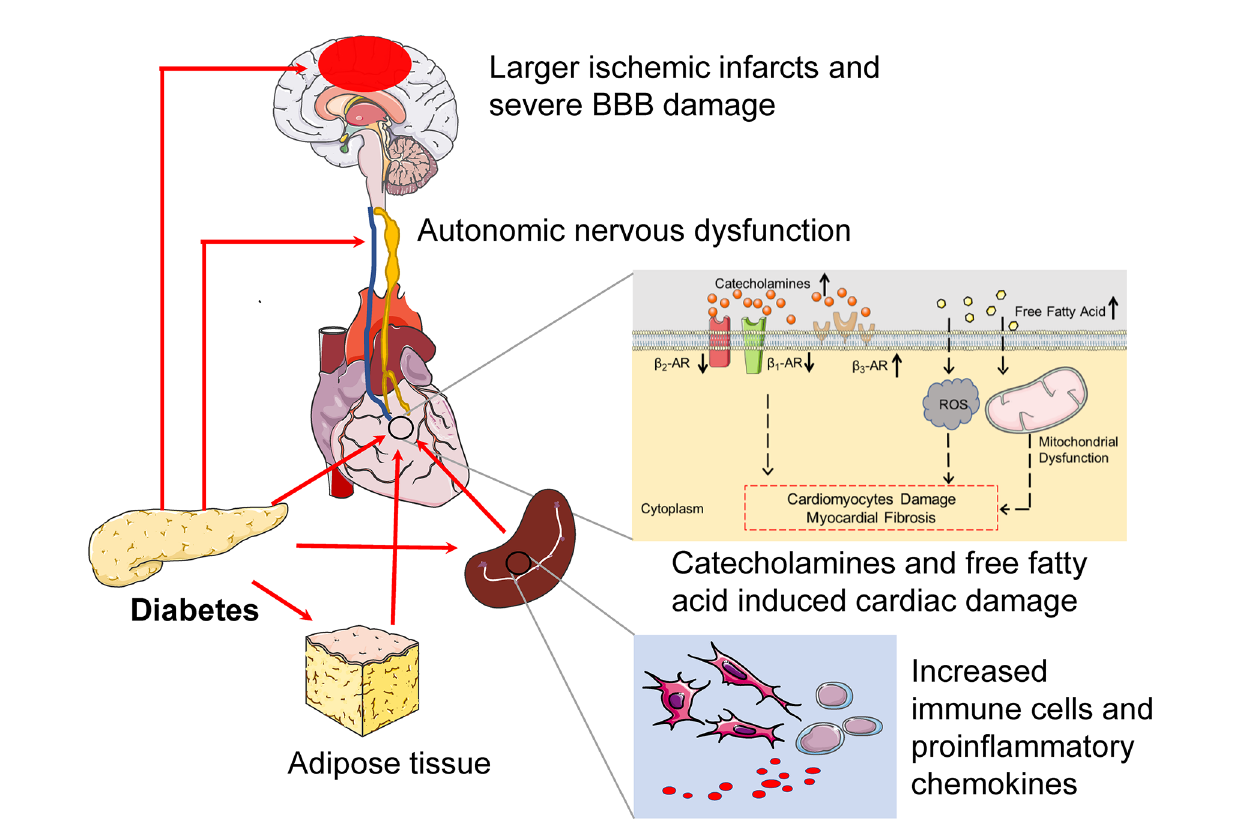
FIGURE 2 | The potential pathogenesis of diabetes exacerbates cerebral-cardiac syndrome. In pre-stroke states, diabetes induces preexisting injury both of the brain and the heart. CAN is a common complication in diabetes, which is characterized by parasympathetic denervation and overactivated sympathetic tone. Furthermore, the expression of b 1 -AR and b 2 -AR decreased, while the b 3-AR increased in the diabetic heart. Diabetes also provides a low-grade systemic in fl ammatory environment, which manifests as increased immune cells and proin fl ammatory cytokine levels. All of these provide a suitable condition for CCS. In the context of diabetes, the larger ischemic infract and severe BBB damage can be detected during the IS onset, which provoke severe systemic in fl ammation and cause severe cardiac in fl ammatory damage. Catecholamines surge also increase after IS in diabetes. Catecholamines surge not only damage cardiomyocyte directly but also act on adipose tissue, which increases free fatty acids. The boosted free fatty acids induce ROS production and mitochondrial dysfunction, which promote cardiac damage. Above all, diabetes induces preexisting cardiac damage and increases heart vulnerability, and cultivates a “ primed ” in fl ammatory microenvironment before IS and severe systemic in fl ammation and catecholamines surge after IS, hence exacerbating CCS. CAN, cardiac autonomic